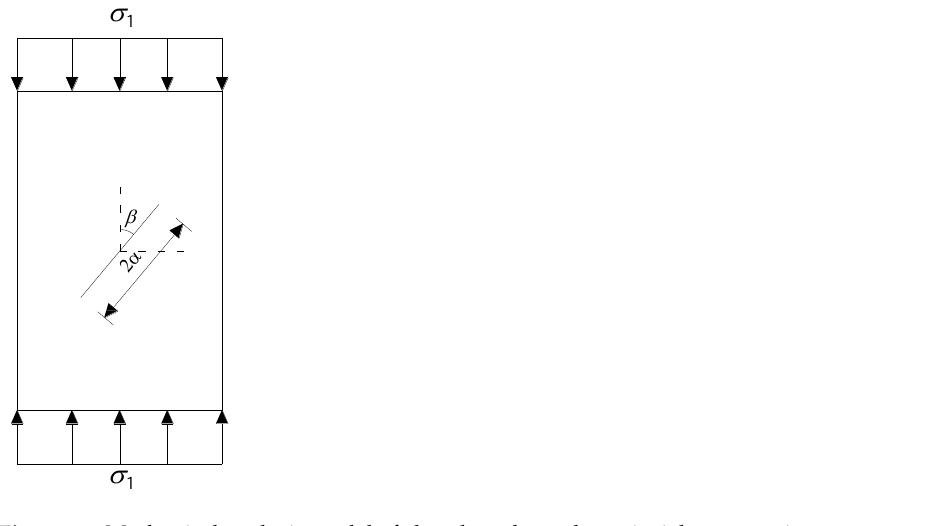
Figure 12. Mechanical analysis model of closed cracks under uniaxial compressive stress.